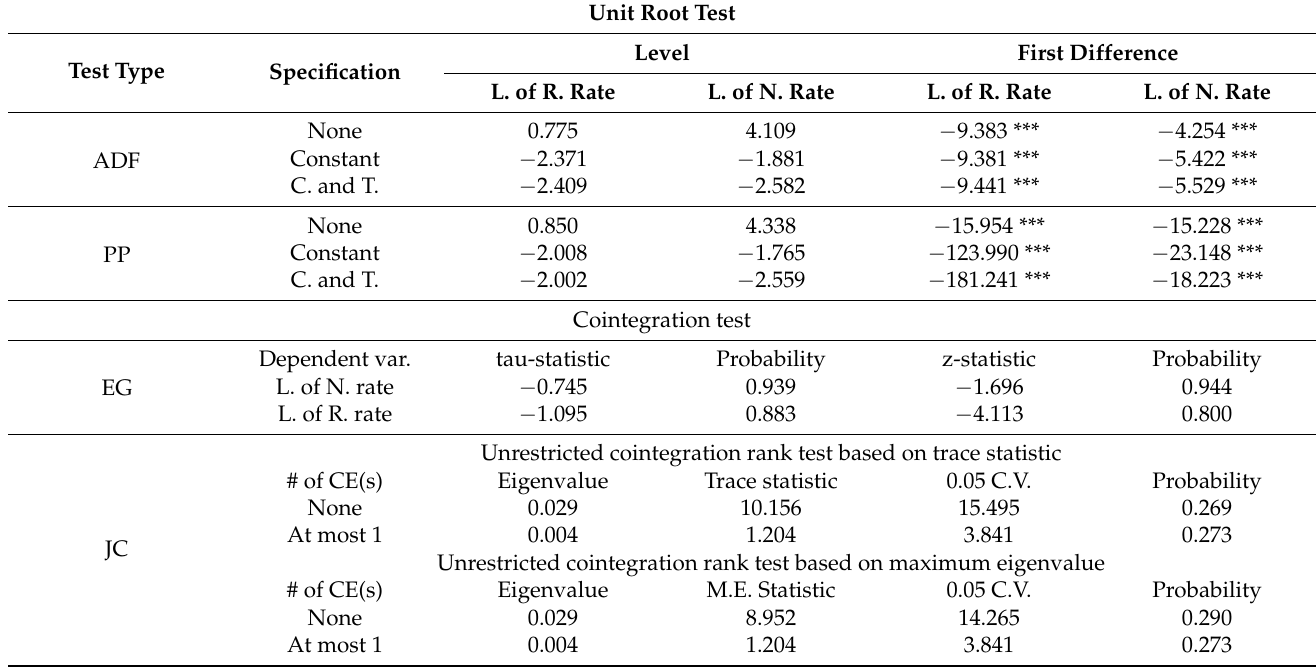
Table 1. Unit root and cointegration